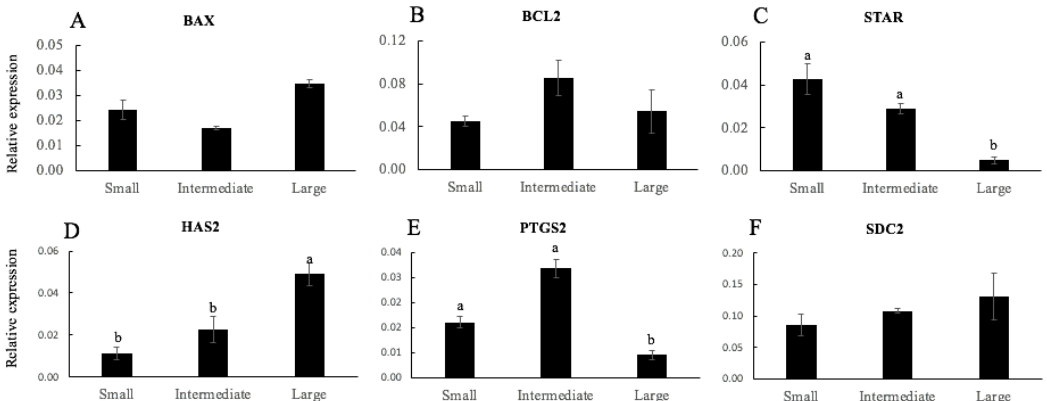
Figure 3. Relative gene expression of mRNA of BAX ( A ), BCL2 ( B ), STAR ( C ), HAS2 ( D ), PTGS2 ( E ), and SDC2 ( F ) of cumulus cells from sheep oocytes according to a clustering analysis of the total diameter (small, intermediate, and large). Different letters denote significant differences ( p < 0.05, at least).